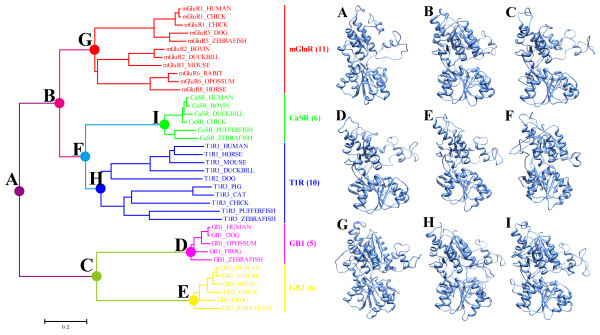
Reconstruction of the ancestral VFTMs from class C GPCRs. Nine extinct ancestral amino acid sequences were inferred from 38 aligned present-day sequences and NJ tree topologies. The three-dimensional (3D) structures of ancestors were modelled on the structure of rat VFTM mGluR1 [PDB: 1EWK].